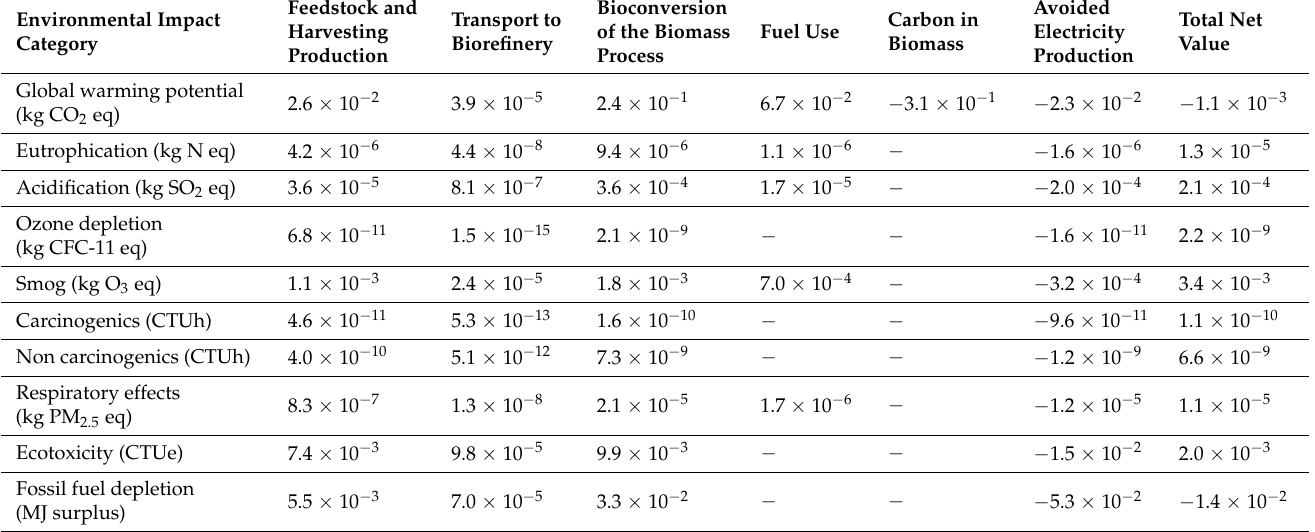
Table 4. Environmental impacts of each life cycle stage of bioethanol